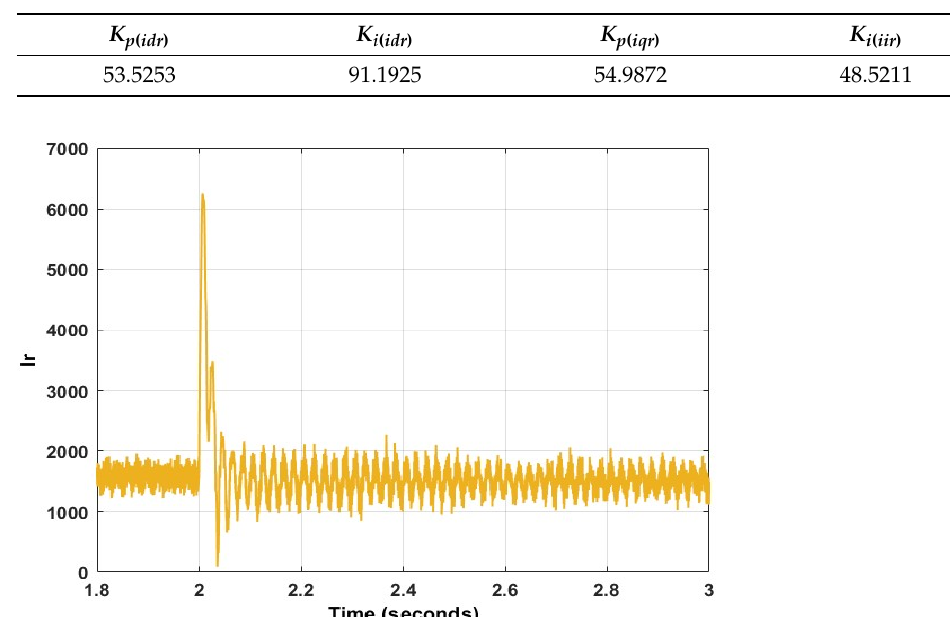
Figure 23. Rotor direct axis current ripple using PI at 70% dip.